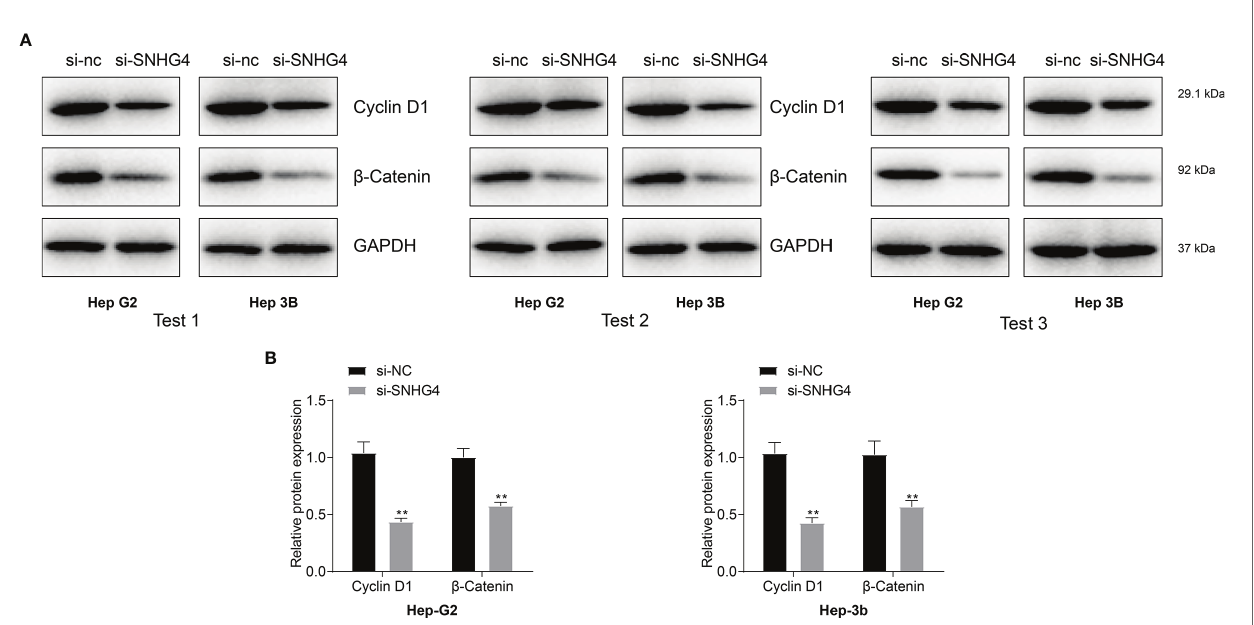
FIGURE 9 | (A) Protein levels of WNT signaling pathway-related molecules ( b -Catenin and cyclin D1) were measured using western blotting in HEP-G2 and HEP-3B cell lines. (B) Knocking down SNHG4 down-regulated the WNT signaling pathway and affected the expression of cyclin D1. * represents p < 0.05; ** represents p < 0.01; *** represents p <